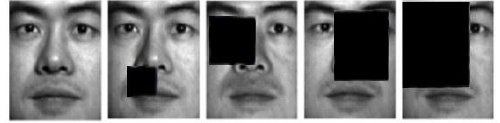
Figure 5. Typical sample images of the corrupted dataset. Table 4. Segmentation results of proposed and existing algorithms on Extended Yale B dataset with multiple block occlusions.